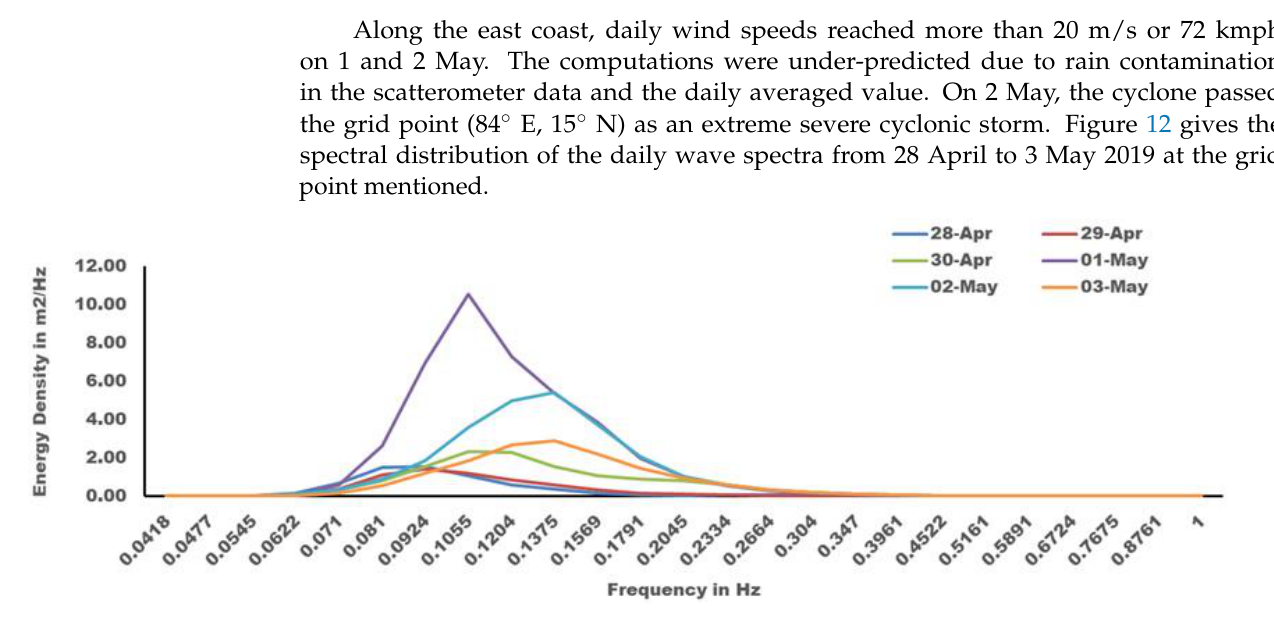
Figure 12. Computed daily wave spectra (m2/Hz) for FANI cyclone at 84° E and 15° N using SCATSAT-1 daily 25 km wind data. SCATSAT-1 daily 25 km wind data.